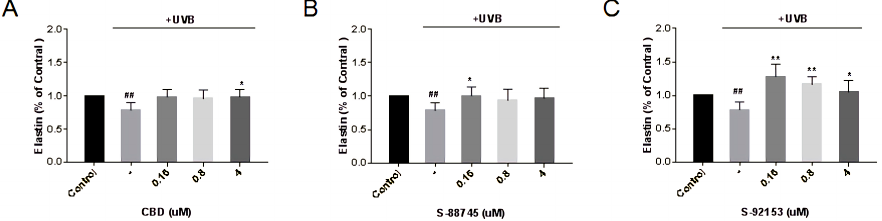
Figure 13. Production of ( A ) CBD, ( B ) S-88745 and ( C ) S-92153 on UV-stimulated elastin in HFF-1. The control group was not stimulated by UV. The UV-treated group (-) was stimulated by UV to cause ECM degradation. The experiments were repeated three times. Each bar illustrates the average ± standard deviation (SD) counted from three experiments. p < 0.05 was considered statistically significant. * p < 0.05 compared to the UV − treated group; ** p < 0.01 compared to the UV − treated group; ## p < 0.01 compared to the control group.